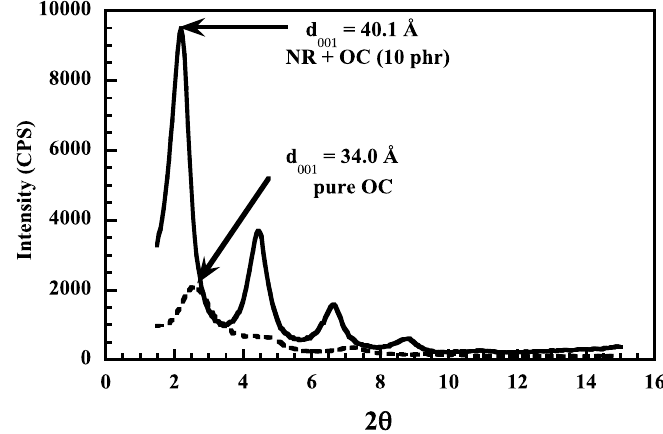
Figure 3. X-ray diffraction patterns for pure organoclay (OC) and for the NR composite filled with 10 phr of OC. Reproduced with permission from [43]. Copyright ACS Publications, 2002.